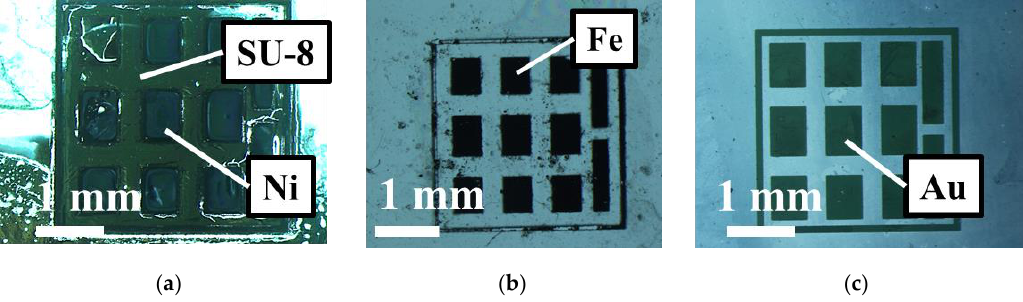
Figure 4. Magnetic tag using different materials. ( a ) Tag created by nickel electrolytic plating. Upper left section is a section without nickel because it is not plated well. ( b ) Tag created using PDMS and iron powder. Iron powder is sufficiently contained in each section. ( c ) Tag created by gold etching.